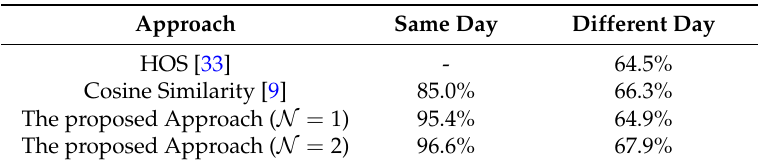
Table 1. Gait authentication accuracies on the MCGILL